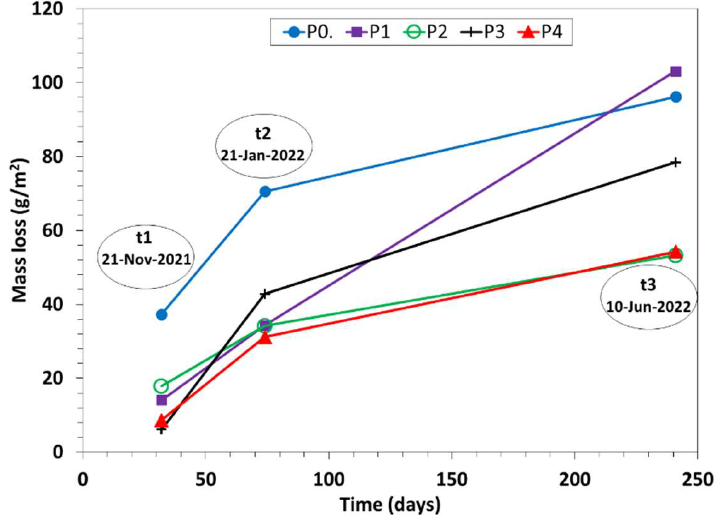
Figure 9. Corrosion rates measured at 32, 74, and 241 days of atmospheric exposure of coupons at the P0, P1, P2, P3, and P4 sites.